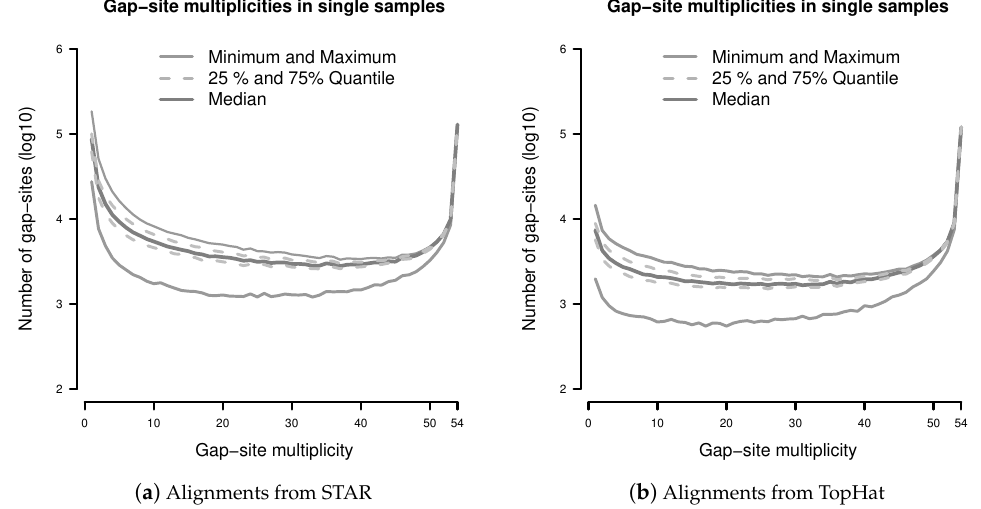
Figure 2. Distribution of gap-site multiplicities in single samples: ( a ) Alignments from STAR; ( b ) Alignments from TopHat. For each gap-site, the multiplicity in the whole batch of 54 samples was determined. Then, for each of the 54 samples, the absolute number of multiplicities contained therein was tabled. Median gap-site numbers (dark gray) together with 25% and 75% quantiles (dashed lines) in 54 samples are shown. The light gray lines indicate minimal and maximal number of